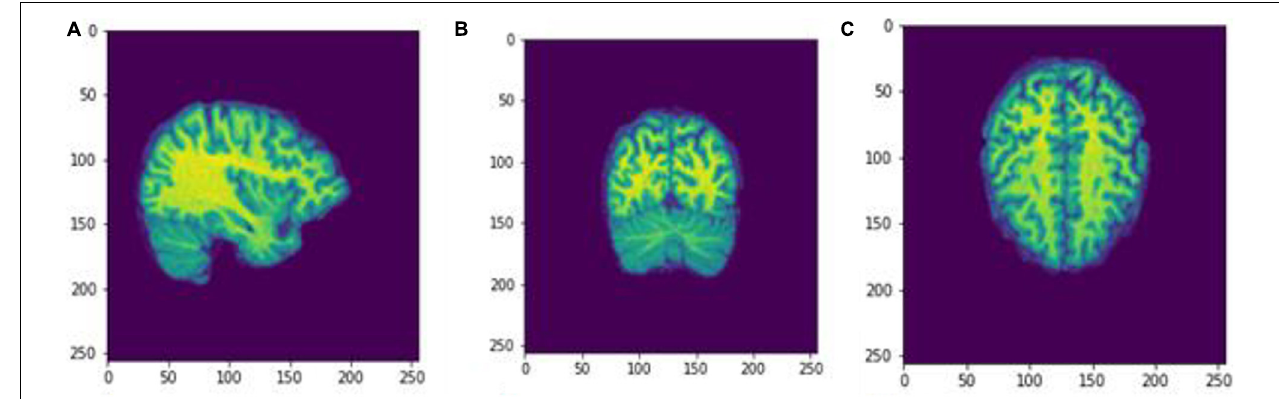
FIGURE 5 | Slices (A) Sagittal, (B) coronal, and (C) axial planes. The output of FreeSurfer of session OAS30001_MR_d0129 as NIfTI files. This volume shall be imported later as a cropped image.npz file into the Box-Counting FD calculator. The images are shown using NiBabel library version 3.2.1 (https://zenodo.org/record/4295521#.YCpJqeqxWMI).